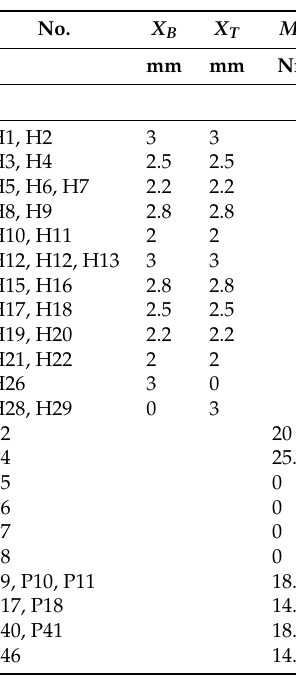
Table 2. Experimental test results for S355J2 steel